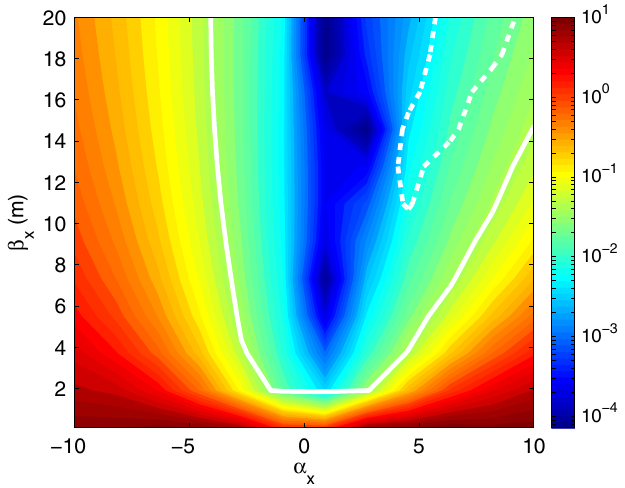
FIG. 7. Locus of C-S parameters that provide an upright lon- gitudinal trace space for the beamlets (dashed solid line). The as a func- false-color map represents the emittance dilution (cid:2)(cid:12) z tion of initial C-S parameters and the solid white line indicates the limit where emittance dilution is 5%. The initial normalized Þ ¼ ð 10 ; 1 Þ (cid:14) m . The dashed white ; " n emittance partition is ð " n x; 0 z; 0 line is computed numerically and corresponds to Eq. (20).